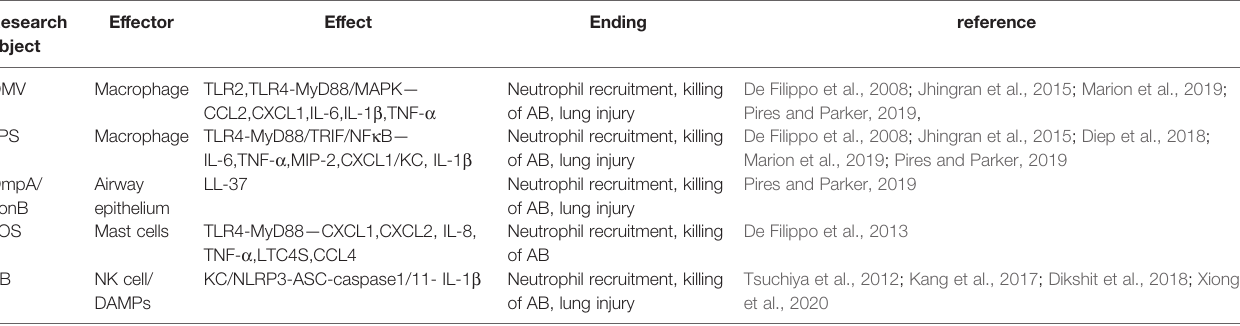
TABLE 1 | Neutrophil and macrophage response in Acinetobacter baumannii